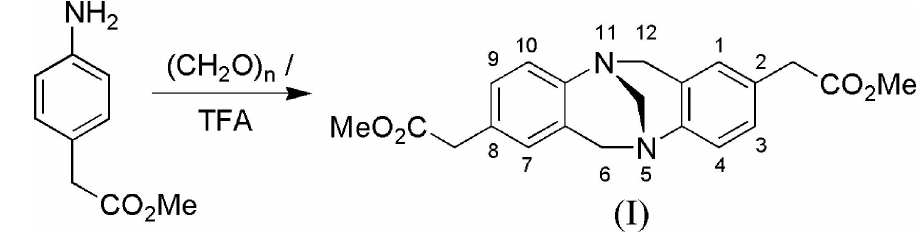
Figure 3 Synthetic scheme for the synthesis of